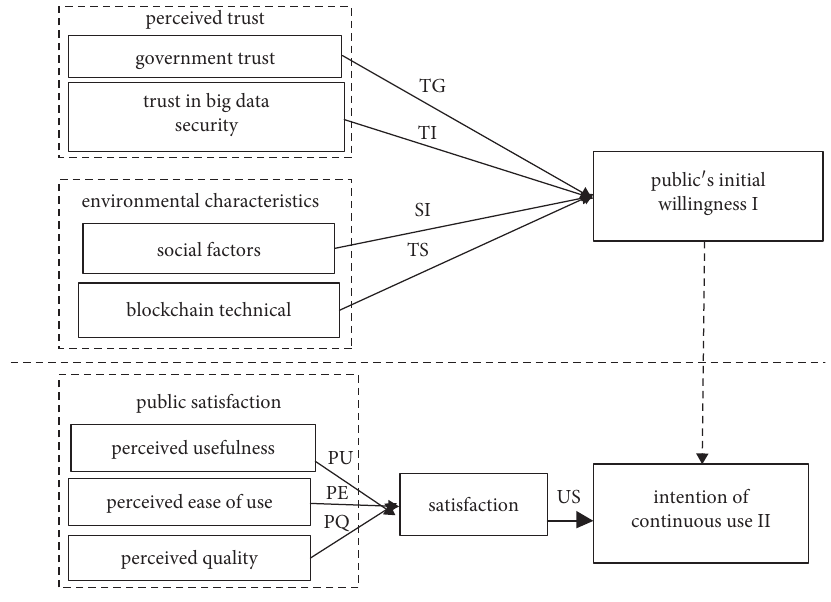
Figure 1: Public adoption model